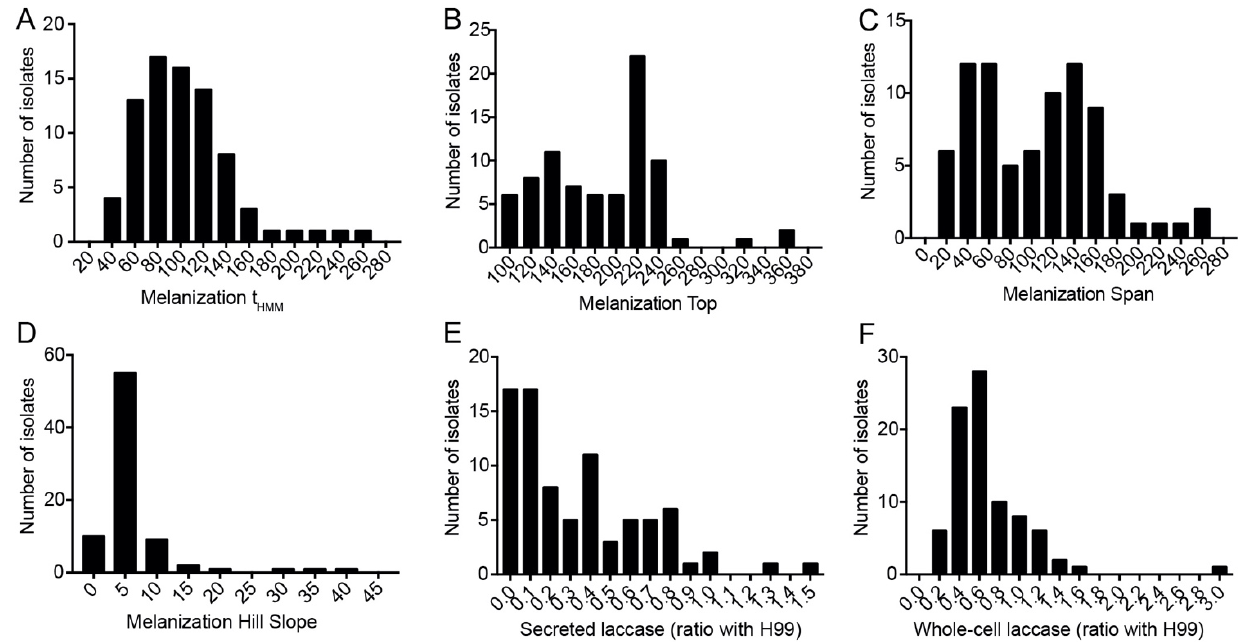
Figure 1. Melanization kinetics of and laccase production by Cryptococcus spp. clinical isolates. ( A – D ) Histograms showing the distribution of the melanization kinetics parameters from clinical isolates. Images of each colony taken throughout 168 h of incubation in melanizing medium were processed and fitted to sigmoidal curves to obtain: ( A ) t HMM —time in hours for the colony to reach half maximum melanization; ( B ) melanization Top—median gray level of the colony at the end of the experiment, which indicates how dark the colony became; ( C ) melanization Span (difference in median gray levels of the colony at the beginning and end of the experiment); ( D ) melanization Slope (slope of the sigmoidal curve at the inflection point, an expression of how fast the colony melanizes. ( E , F ) Histograms showing the specific secreted and whole-cell laccase activity from clinical isolates. Experiments were repeated at least twice and had similar results. Frequency distribution of secreted laccase activity, n = 82 and ( F ) frequency distribution of whole-cell laccase activity, n =